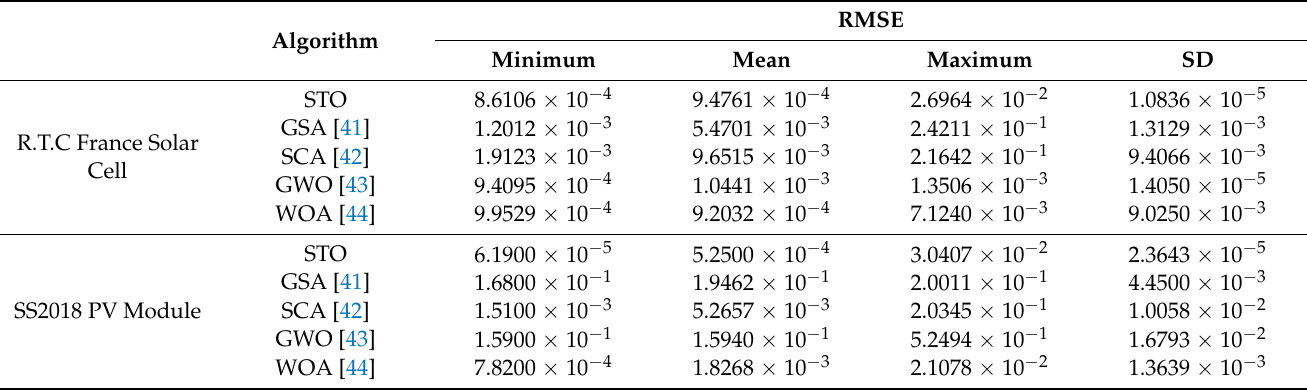
Figure 6. Convergence plot for the SS2018 PV module. Table 6. Statistical RMSE results for various techniques for the R.T.C France solar cell and the SS2018 PV module.